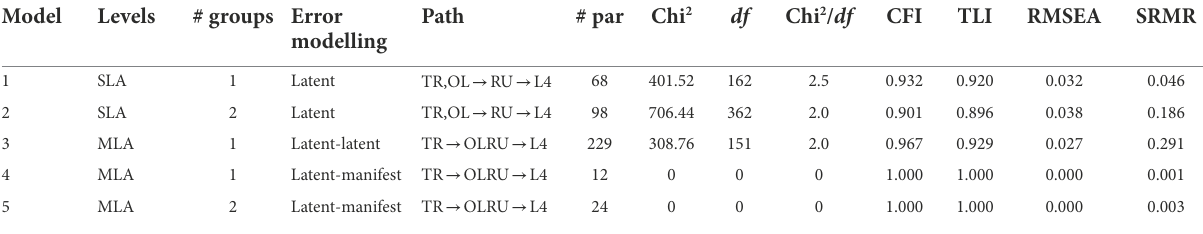
TABLE 4 Model fit indices for the structural models on single-level and multilevel for both single group and multigroup analysis and variants of error modelling. Model